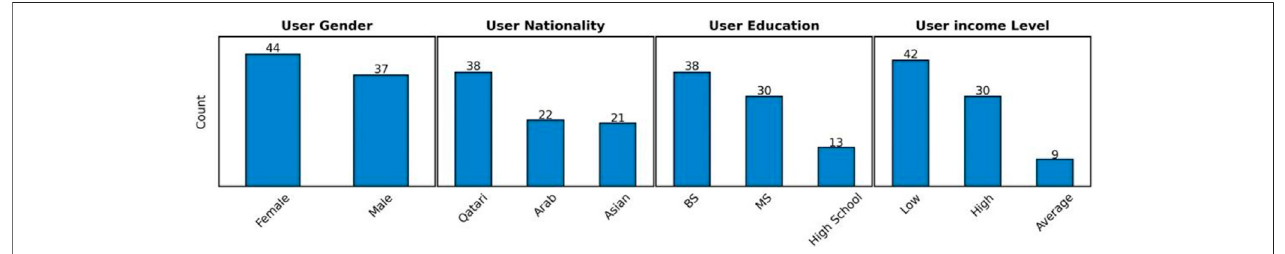
FIGURE 7 | Demographic and socioeconomic factors of the sample.